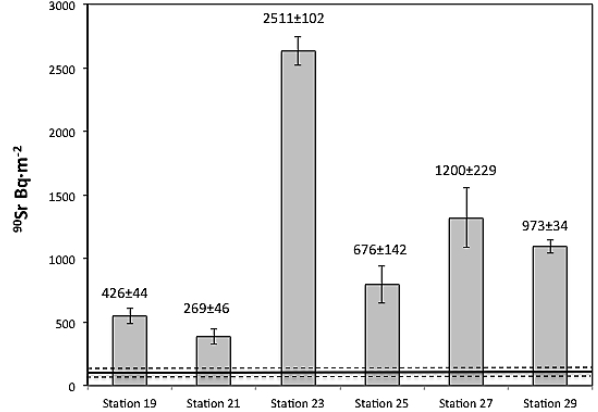
Fig. 5. Total inventories of 90 Sr in the upper 100m of the water column at stations 19, 21, 23, 25, 27 and 29. The solid line rep- resents the background value for this area (120 ± 40Bqm − 2 ) , and the numbers above the bars indicate the Fukushima-derived inven- tory (subtracting the